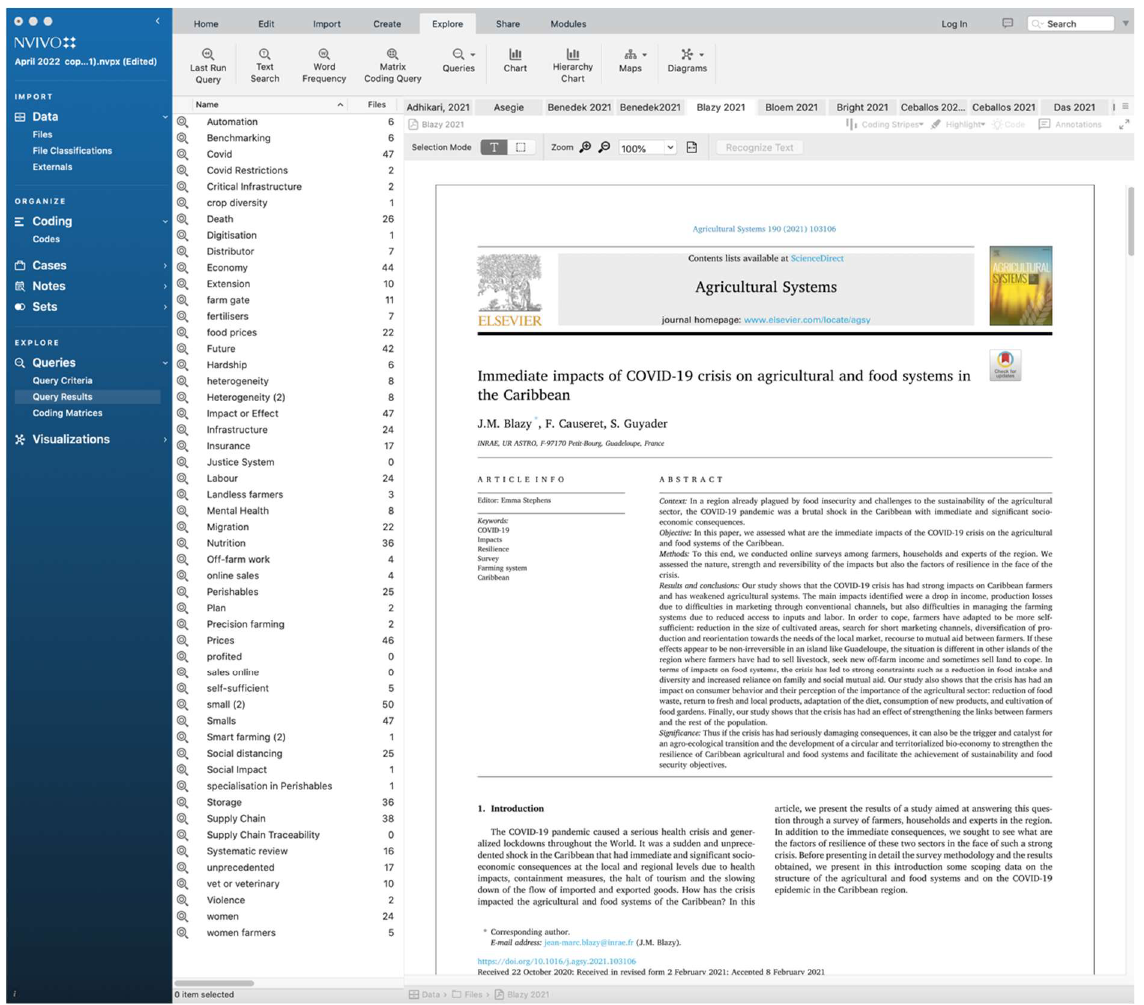
Figure 3. NVivo text searches.